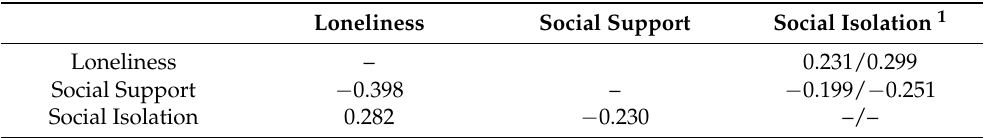
Table A2. The parametric correlations between the social variables and the non-parametric correla- tions with Social